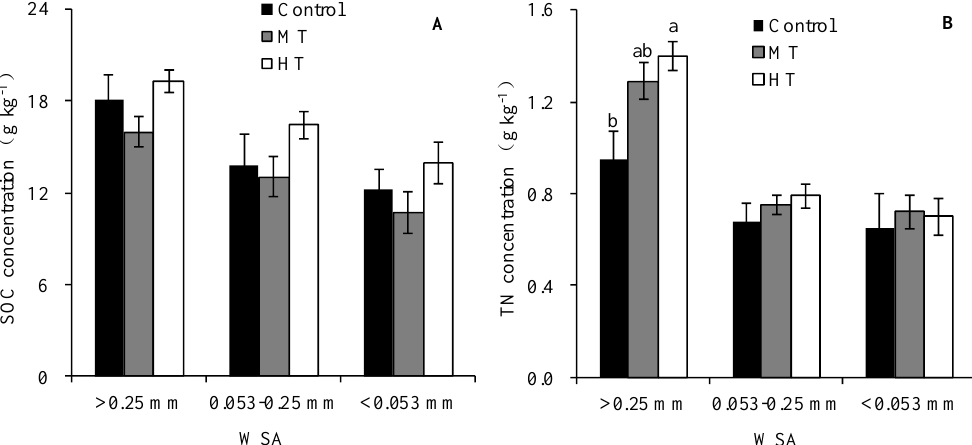
Figure 1. ( A ): SOC concentration in each aggregate size fraction between the treatments; ( B ): TN concentration in each aggregate size fraction between the treatments; Control: conventional management model, MT = moderate thinning, and HT = heavy thinning; n = 3, Figure shows means and standard error bars. Different lowercase letters above bars indicate significant differences among the three treatments ( p < 0.05).